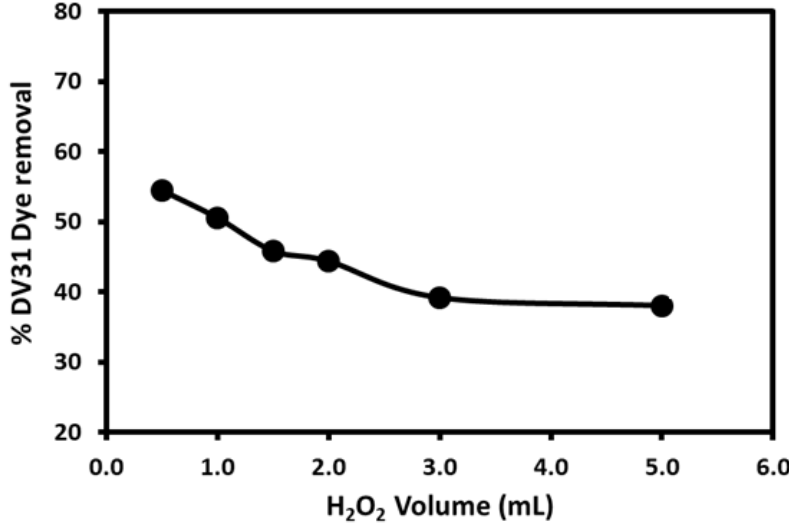
Figure 7. Effect of H 2 O 2 volume on the removal of DV31 dye from aqueous solution using G CuO NPs. (Experimental conditions: DV31 dye concentration 25 mg/L; sample volume 100 mL; 10.0 mg CuO NPs; pH 8.6 and temperature at 25 °C).